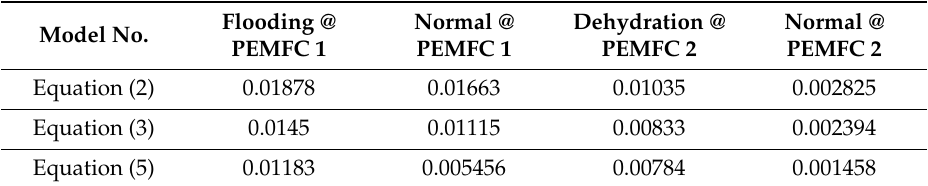
Table 11. Simulation accuracy of three V-I models.